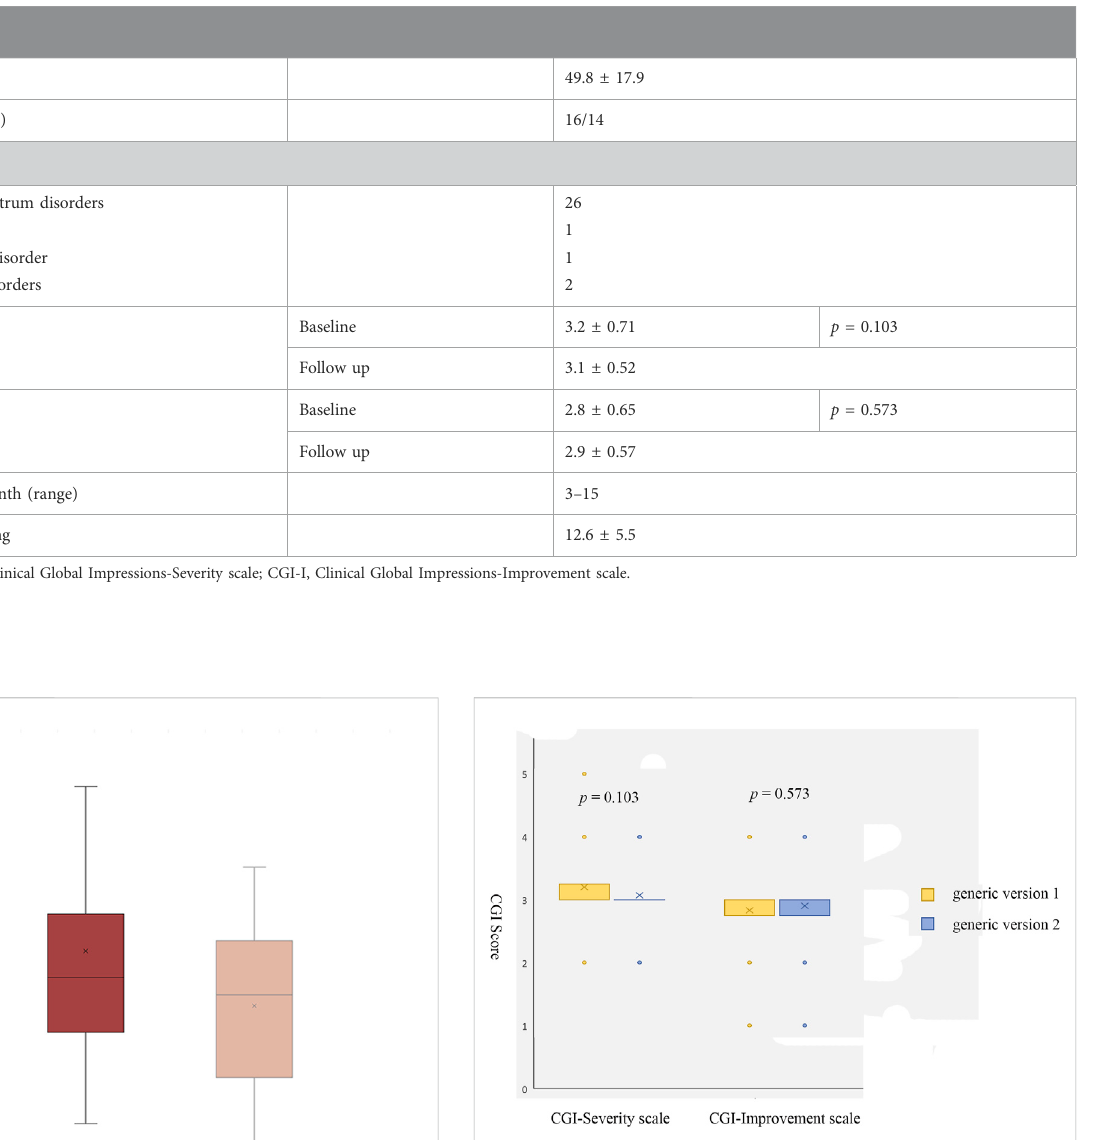
TABLE 1 Demographic and clinical pro fi les of patients.